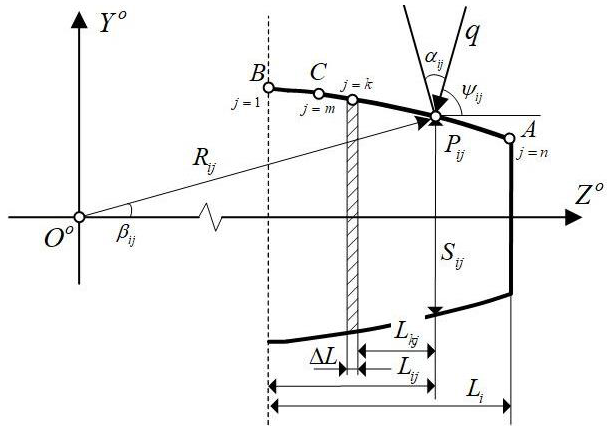
Figure 8. The model of equal division for meshing deformation.